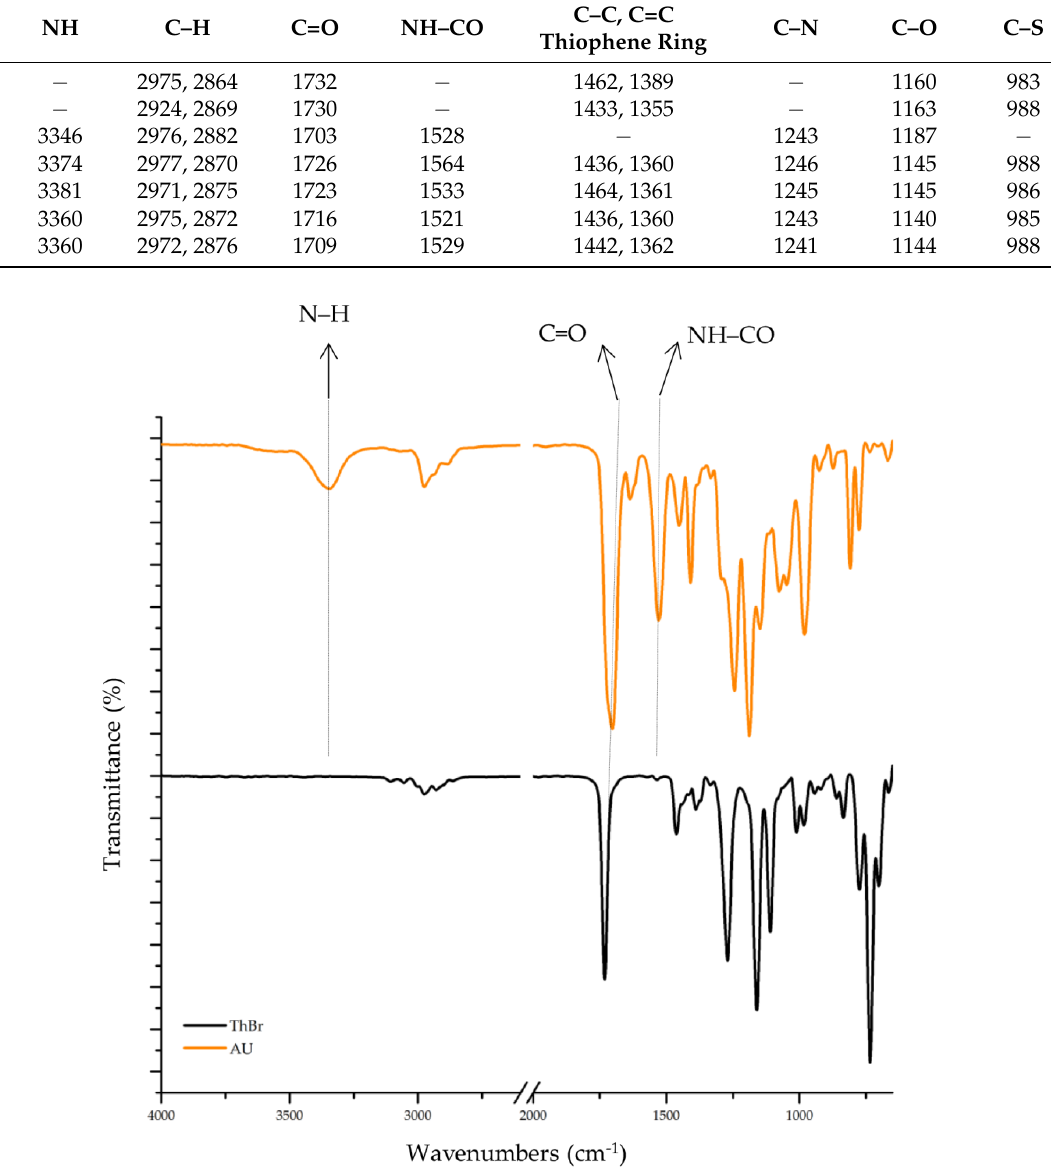
Table 1. Relevant FTIR frequencies (cm −1 ) for monomers and polymers [34,39].